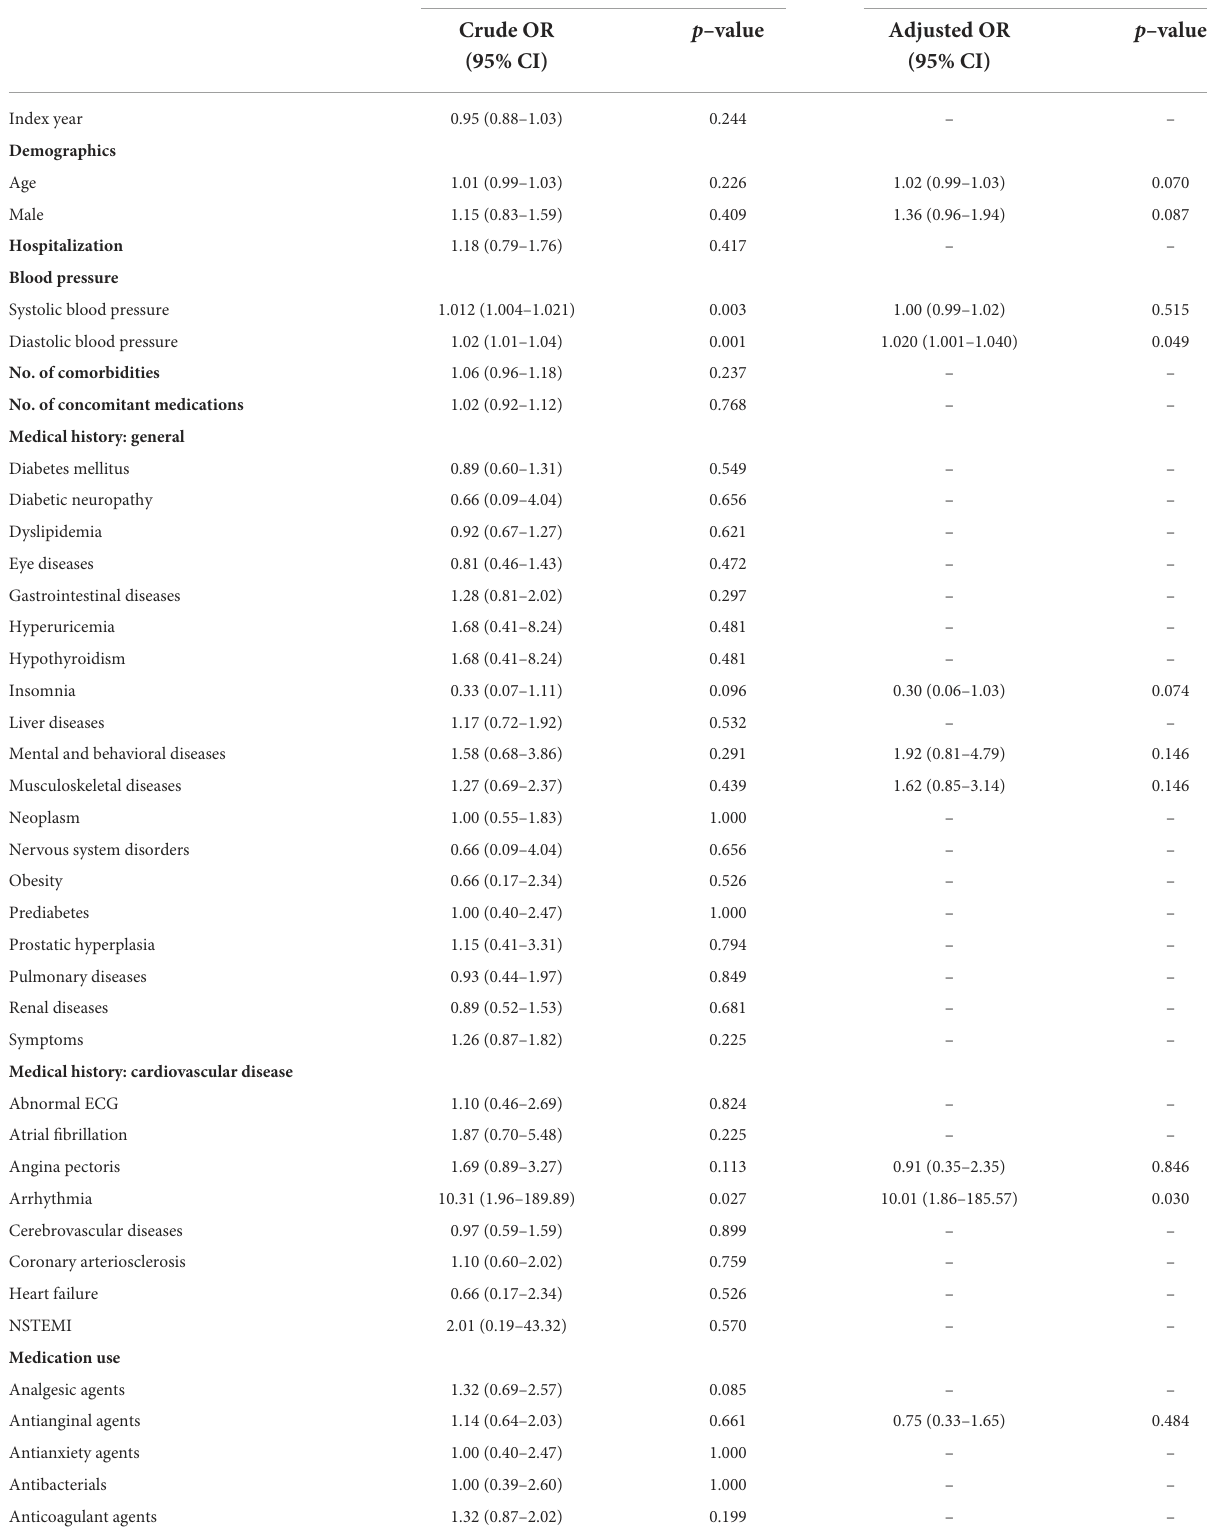
TABLE 4 Results of univariate and multivariate analyses assessing the association between factors and changes in anti-hypertensive medications.